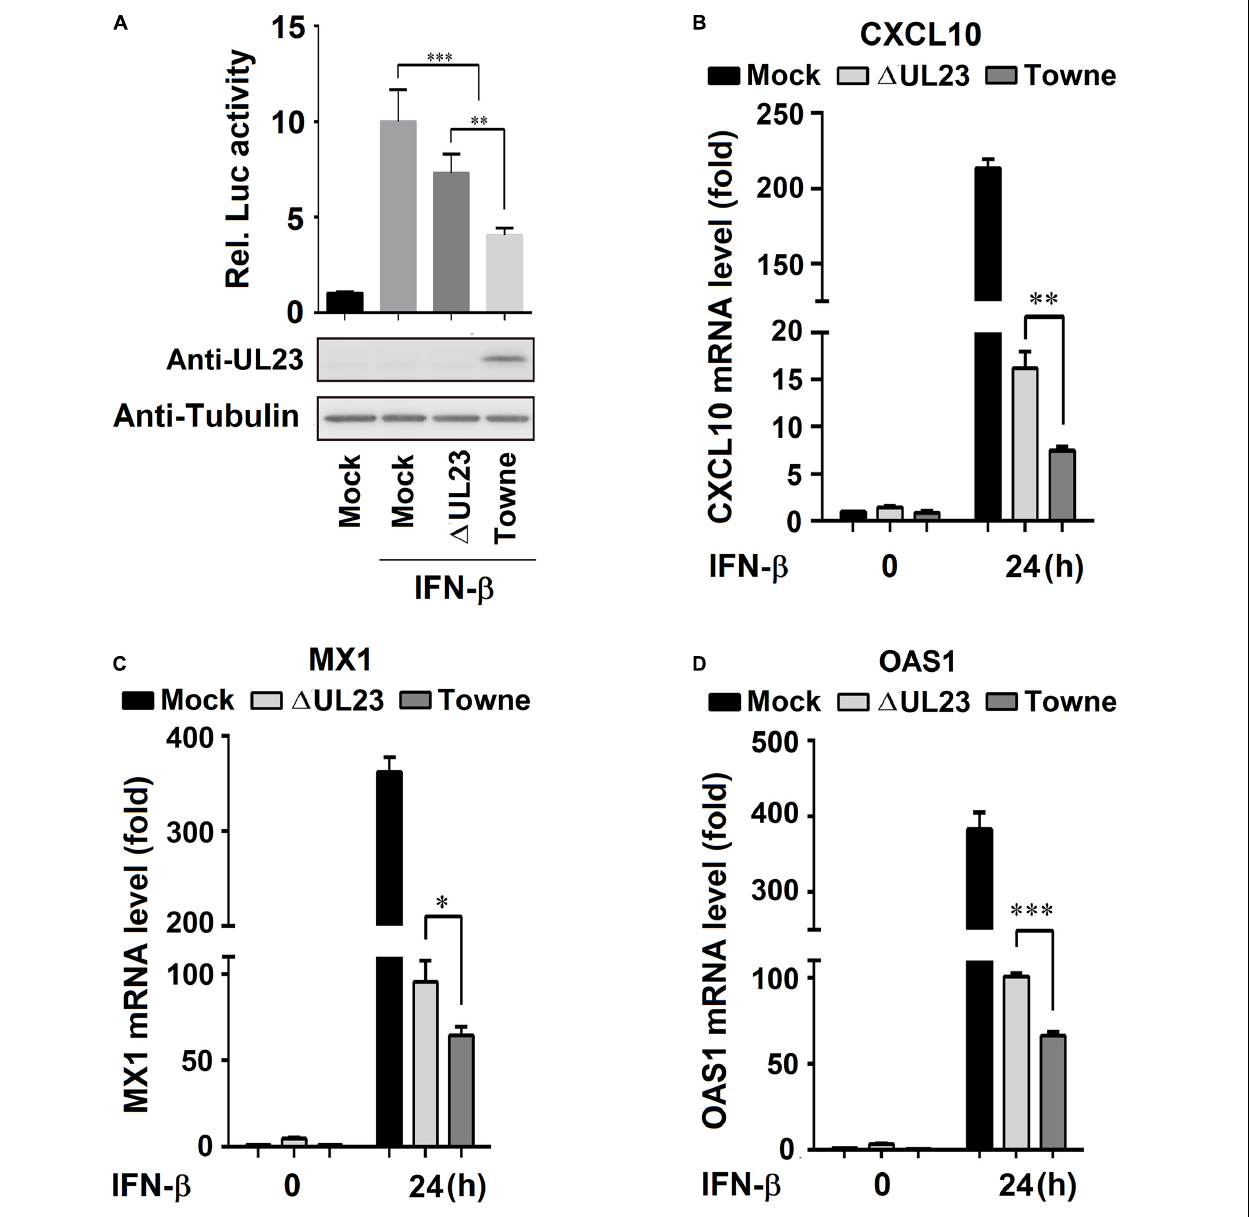
FIGURE 2 | UL23 represses type I IFN-induced transcription of IFN-stimulated genes (ISGs) during HCMV infection. (A) U251 cells were cotransfected with ISRE-Luc reporter and pRL-TK reporter. At 24 h post-transfection, cells were infected with mock or with HCMV or HCMV– (cid:49) UL23 (MOI = 3) for 24 h before luciferase assays. UL23 expression was measured through the Western blot assay, with Tubulin as a loading reference. (B–D) HCMV- (cid:49) UL23 or WT HCMV (MOI = 3) was used to infect U251 cells for 24 h, followed by 100 U/ml IFN- β treatment for 24 h. The (B) CXCL10 , (C) MX1 , (D) and OAS1 mRNA expression was measured through qRT-PCR, with GAPDH as the reference. Each assay was conducted thrice. Data are shown as mean ± SD. * p < 0 . 05, ** p < 0 . 01, *** p < 0 . 001 (unpaired, two-tailed Student’s t -test). Data are representative of three independent experiments with similar results.